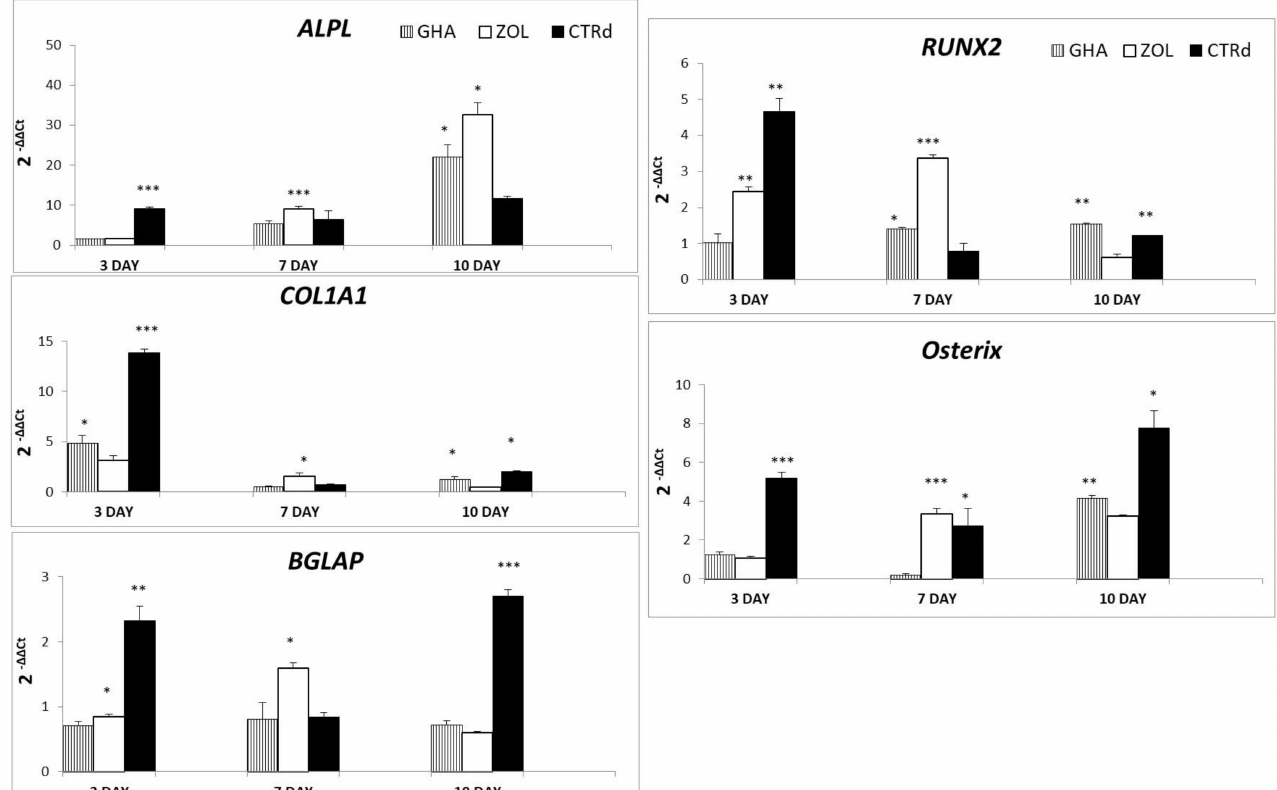
Figure 6. Realtime PCR results of the major osteoblastic lineage genes; hMSC were cultured on GHA and GHAZOL 3D fracture model and on CTRd for 3, 7 and 10 days, thereafter RNA was extracted and the relative gene expression of ALPL , COL1A1 , BGLAP , RUNX2 and OSTERIX was calculated by normalizing to a housekeeping gene ( GAPDH )(*: p < 0.05; **: p < 0.005, ***: p < 0.0005). Both RUNX2 and OSTERIX , genes representative of osteoblastic differentiation, are